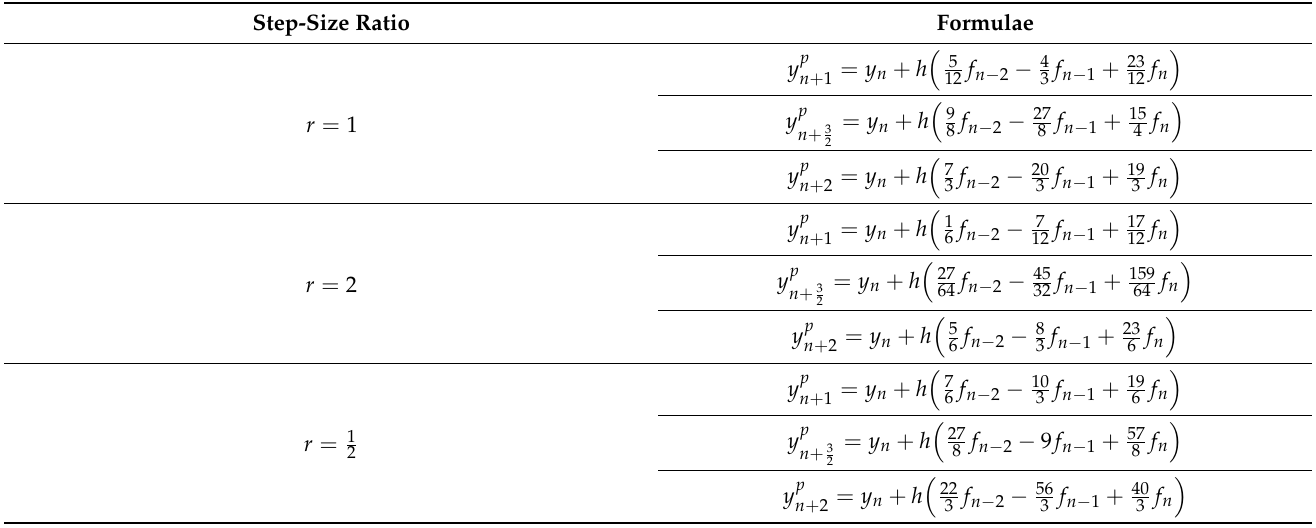
Table 2. Predictor formulae for the VSHBM at different step size ratios. Step-Size